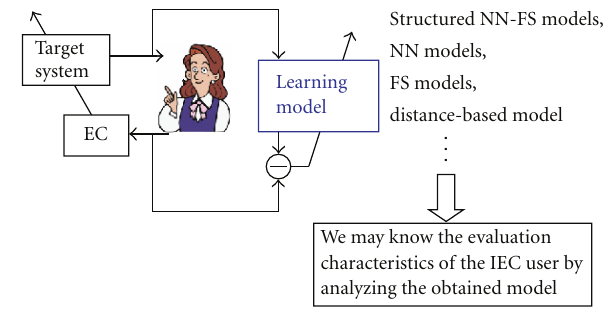
Figure 9: Making an evaluation model of an IEC user.